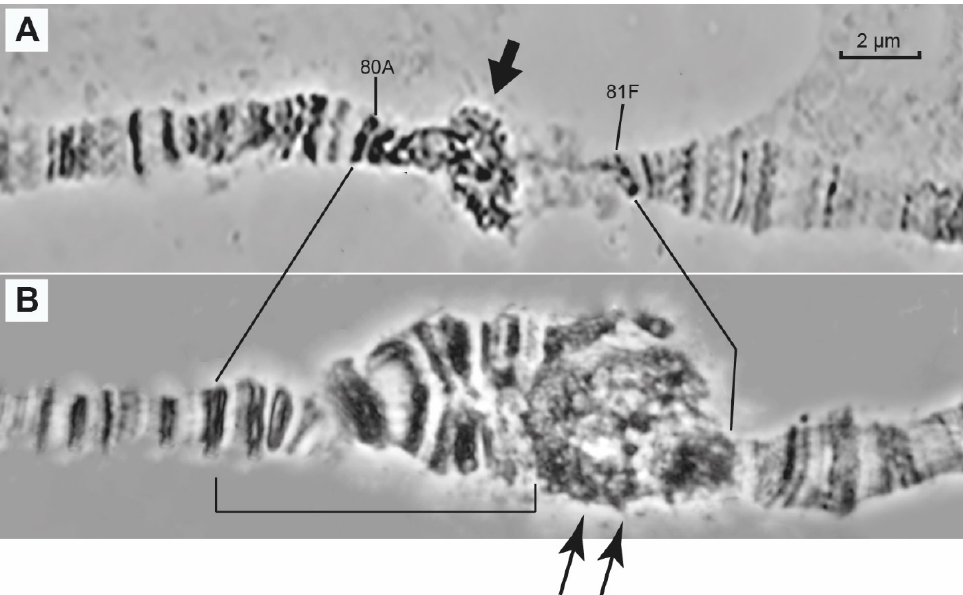
Figure 1. Morphology of pericentromeric chromatin between regions 80A and 81F of polytene chromosome 3 of Drosophila melanogaster in wild type (Oregon-R, the control) ( A ) and Rif1 1 mutants ( B ). The arrow in ( A ) points to a fragment of mesh-like pericentromeric heterochromatin. The banded part of polytenized heterochromatin in the mutants is delineated by the bracket ( B ) and the net-like heterochromatin appearing in the Rif1 chromosomes is pointed to by the arrows ( B ). Scale bar value is the same for both figures.